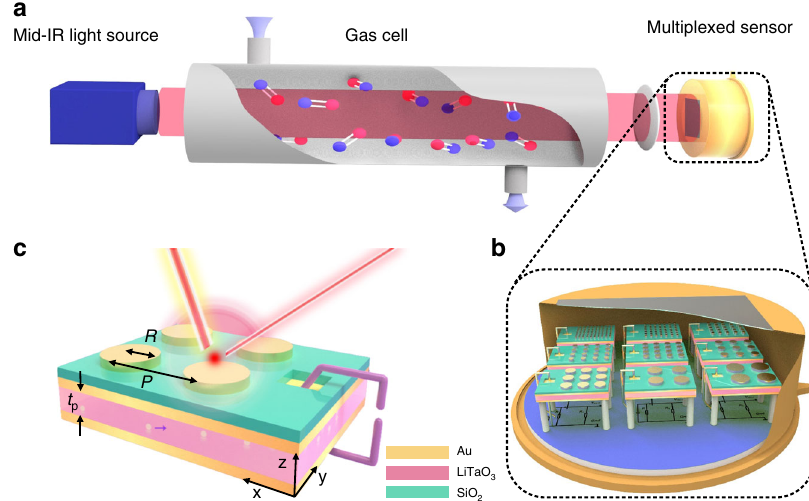
Fig. 1 An overview of the proposed non-dispersive infrared (NDIR) architecture using metamaterial enabled narrowband pyroelectric detectors. a A schematic diagram of the gas sensing system based on the proposed NDIR architecture with an array of narrowband PMA integrated pyroelectric elements used as the spectral sensor. The system is composed of three parts: the broadband light source, the gas cell, and the multi-element sensor together with necessary focusing optics. b The joint package of the multiple pyroelectric elements with different detection wavelengths. c The device geometry of the narrowband detection element. From the top to the bottom are: the Au nanodisk antenna, the silicon dioxide spacer, the gold backplate that is also used as the top electrode of the pyroelectric element, the lithium tantalate (LT) substrate, and the gold bottom electrode. The length of the smallest repeatable unit is the periodicity P and the radius of the nanodisk is R . The area size of each absorber is 1 ×1mm and the thickness t p of the LT substrate is 75 μ m. To provide electrical access to the gold backplate buried underneath the silicon dioxide spacer, a window area beside each absorber is opened by removing the